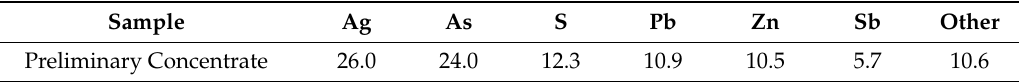
Table 1. Composition of silver concentrate used in small scale experiments in (wt. %).